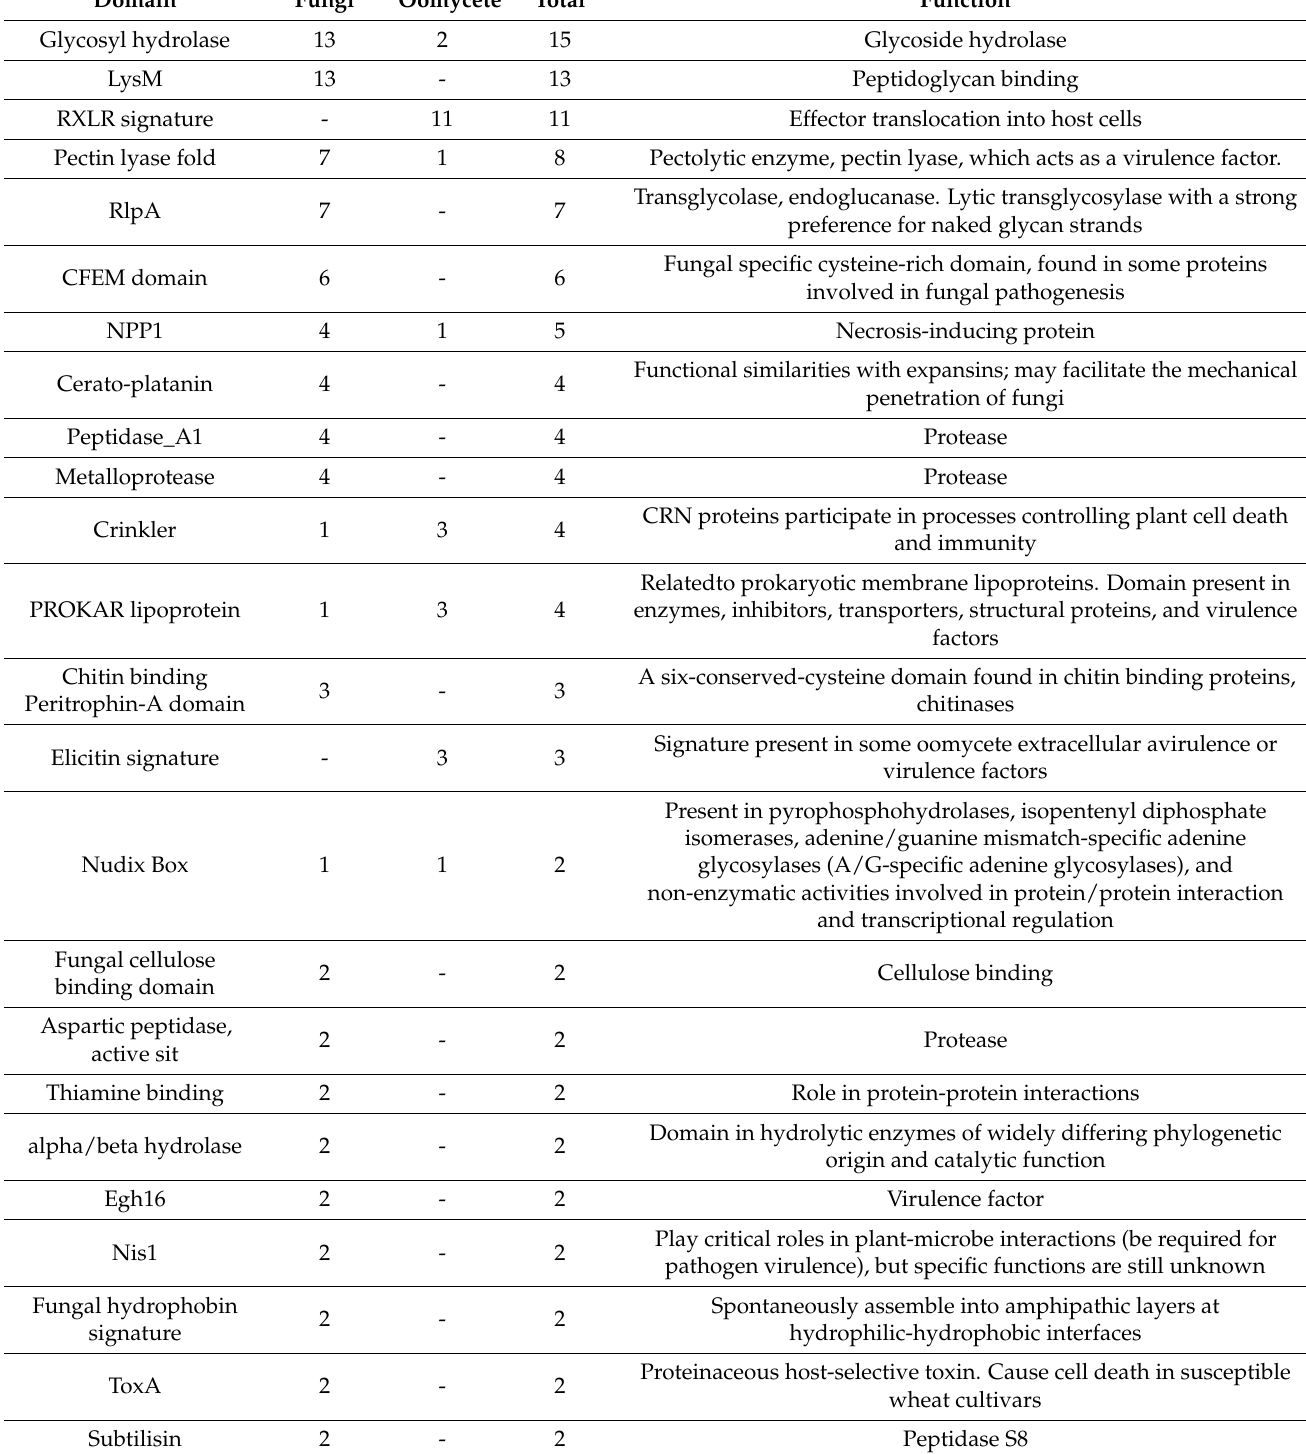
Table 4. Functional domains identified in fungal and oomycete